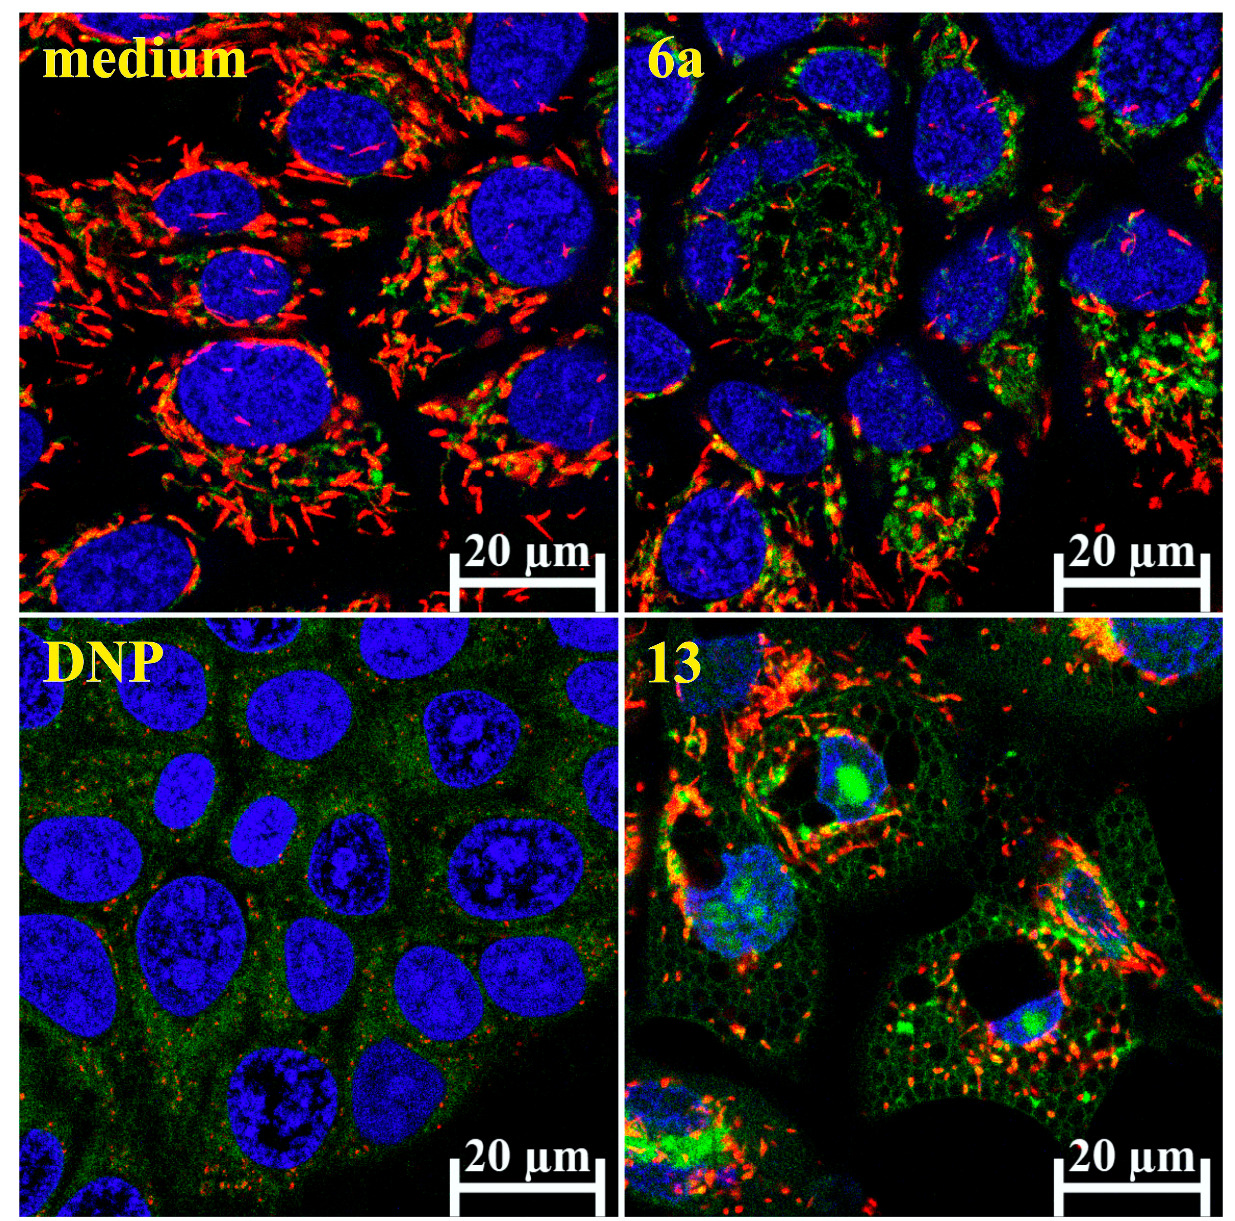
Figure 8. Morphological changes in Detroit 562 cells. Besides mitochondrial dysfunction (green color), JC-1 Dye (labels the well-functioning mitochondria with red color) revealed vacuolated cytoplasm and nuclear shrinkage in Detroit 562 cells, after 28 h of treatment with hybrid 13 at 2.5 µ M. DNP was used as positive control for mitochondrial membrane depolarization. Nuclei were visualized by membrane-permeable dye DRAQ5 (blue).